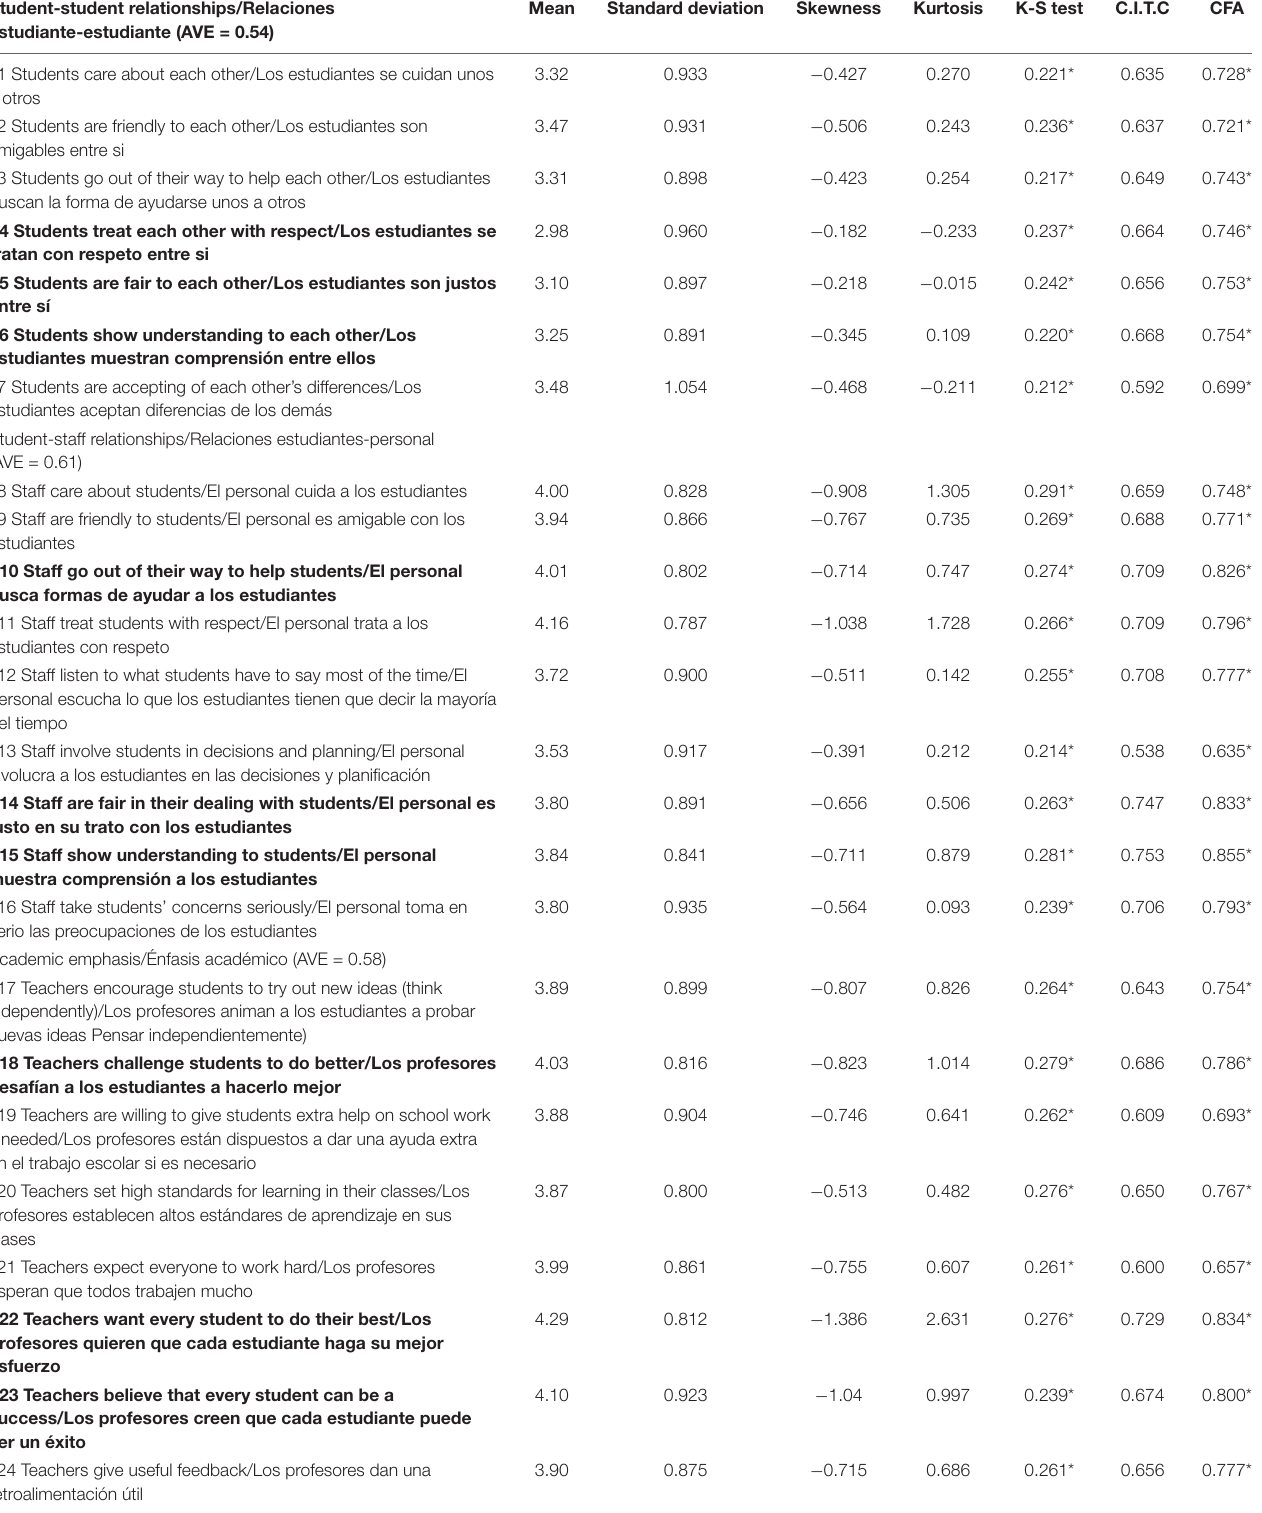
TABLE 1 | Descriptive statistics, corrected item-total correlation and confirmatory factor